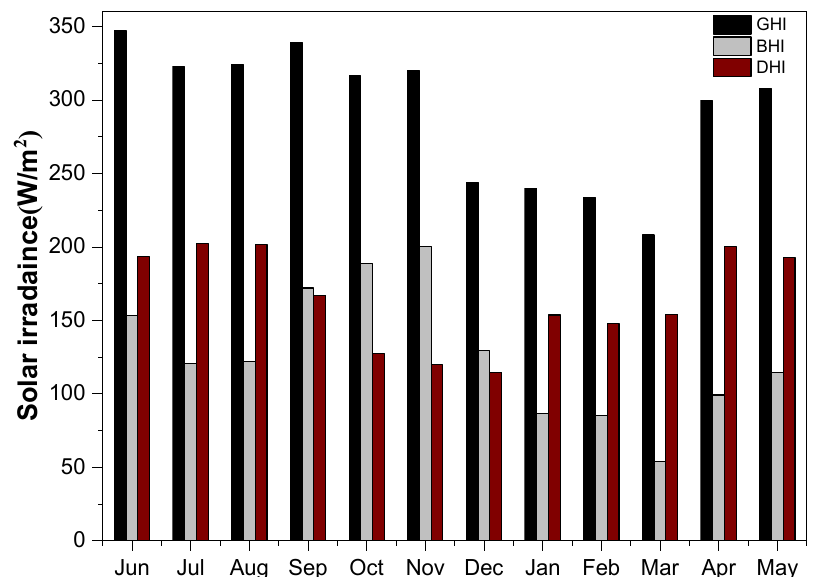
Figure 4. Monthly average daily horizontal solar radiation between June 2019 and May 2020 .